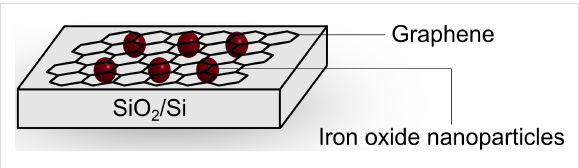
Figure 6: Iron oxide decorated graphene layer on a SiO 2 /Si wafer for CNT growth. The nanoparticles are located between the substrate and the CVD graphene. For a schematic of the complete growth process see Figure